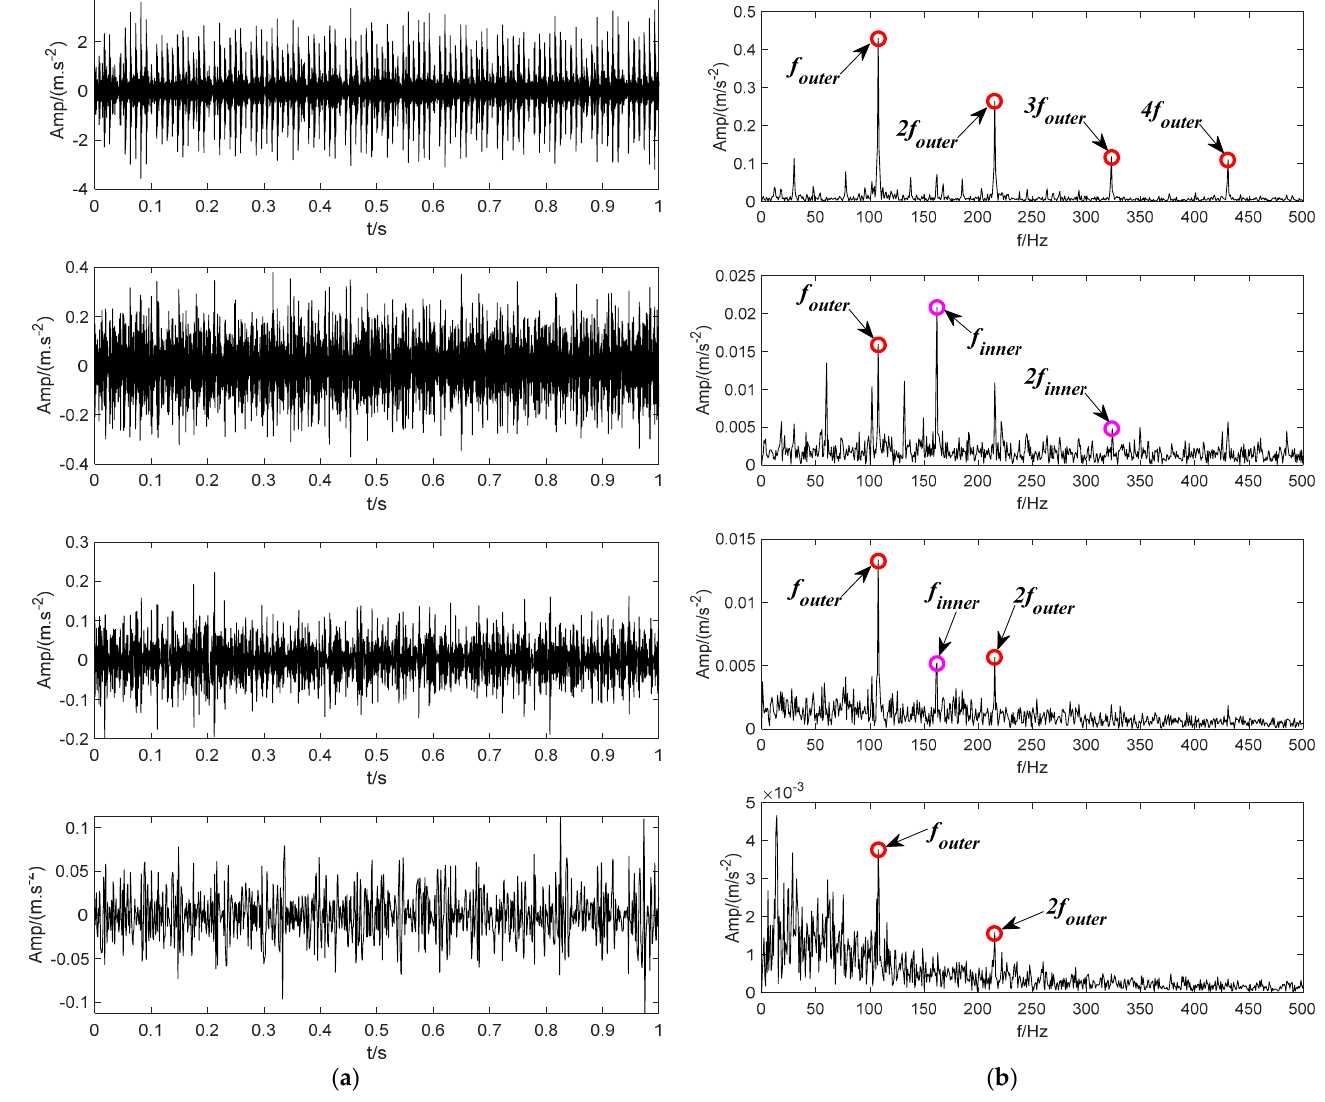
Figure 20. Performance evaluation of ITD method. ( a ) The PRC components obtained by ITD and ( b ) their envelope spectrums.